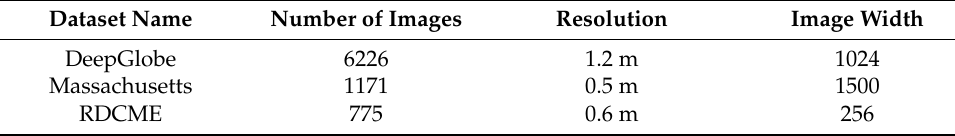
Table 1. Comparison of RDCME, DeepGlobe, and